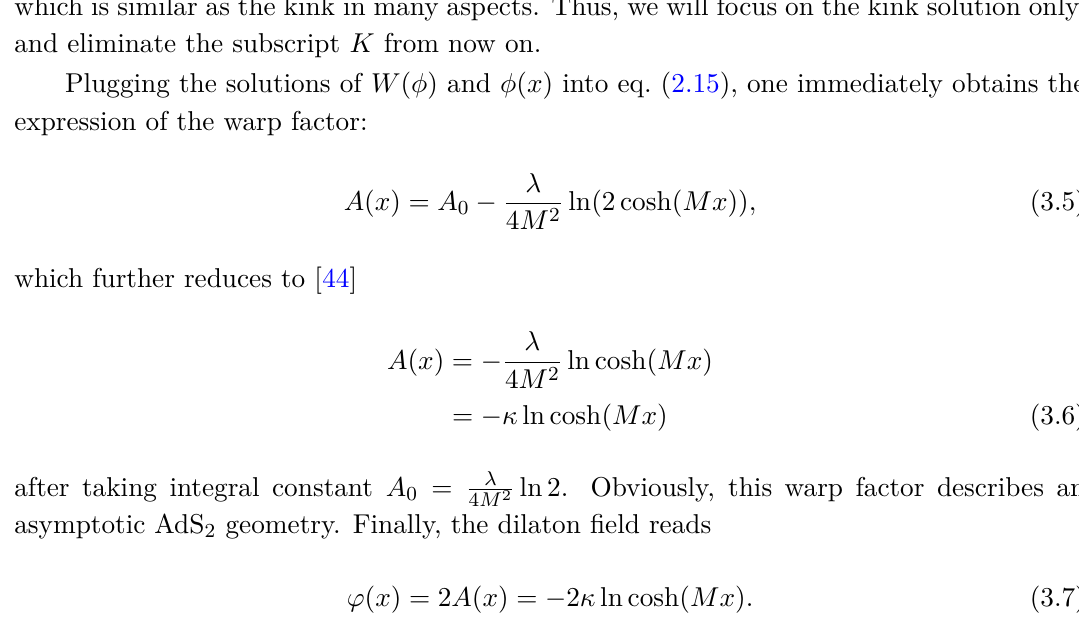
Figure 1 . The shapes of some important variables in Stötzel’s solution, incluting (a) scalar field, (b) warp factor and the dilaton field. The parameters are taken as κ = 1 , m = therefore M = 1 and Λ = 2